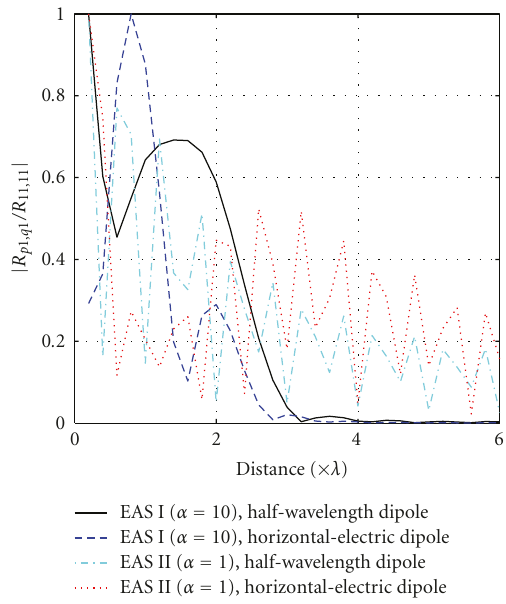
Figure 9: Spatial correlation coe ffi cient , with respect to vertical distance in wavelength λ between two directional antennas located at the center of the azimuthal plane (one is located at z = 0), considering two di ff erent EASs: EAS I ( α = 10) and EAS II ( α = 1), Laplacian AAS pdf ( a = 0 . 25 rad), using exponential DP with τ = 3 . 33microseconds, σ = 2microseconds, f 1 = f 2 = 1 GHz, and for a MIMO communication system at the transmitter station (BS); employing half-wavelength dipole or horizontal-electric